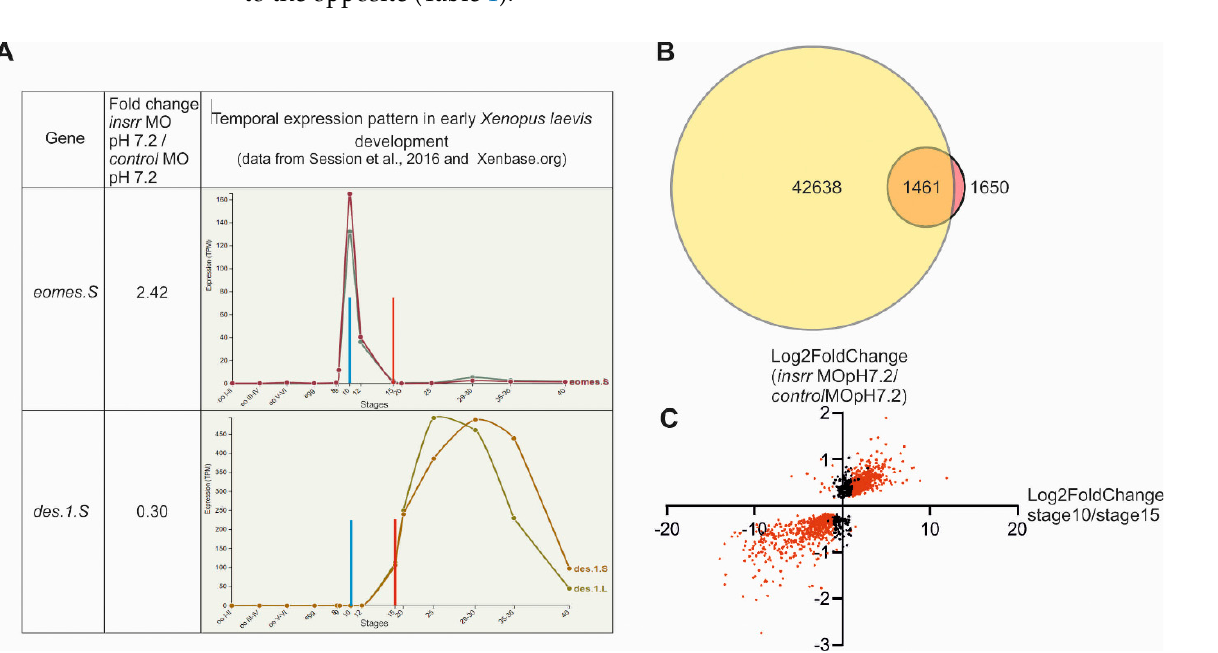
Figure 2. ( A ). PCA analysis of RNA-seq data of control embryos and insrr MO1 knockdown em- bryos after incubation in pH 7.2 or 8.5 media. ( B ). Representation of upregulated and downregu- lated DEGs (padj < 0.05) of control embryos and insrr MO1 knockdown embryos after incubation in pH 7.2 or 8.5 media. ( C ). The density plot of genes on a field of log2(FoldChange) vs. log10(baseMean) was plotted after differential expression analysis of transcriptomes between con- trol and insrr MO1 knockdown embryos. DEGs with padj < 0.05 are colored in red and other genes are colored in grey. ( D ). Same plot with multicolor indication of DEGs (padj < 0.05) which were downregulated after alkali treatment of insrr MO1-injected embryos. ( E ). Same plot with multicolor indication of DEGs (padj < 0.05), which were upregulated after alkali treatment of insrr MO1-injected embryos .